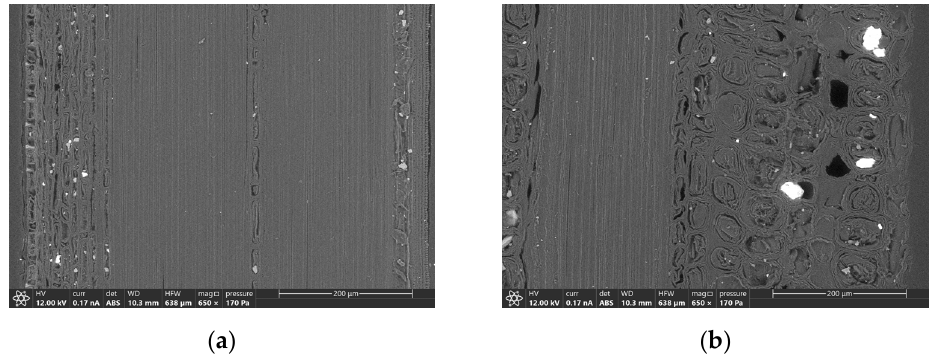
Figure 14. Backscattered electrons ESEM micrograph of the longitudinal section of an aged sample (192 h), taken from the external surface ( a , on the left) to the inner surface ( b , on the right) of the culm wall.